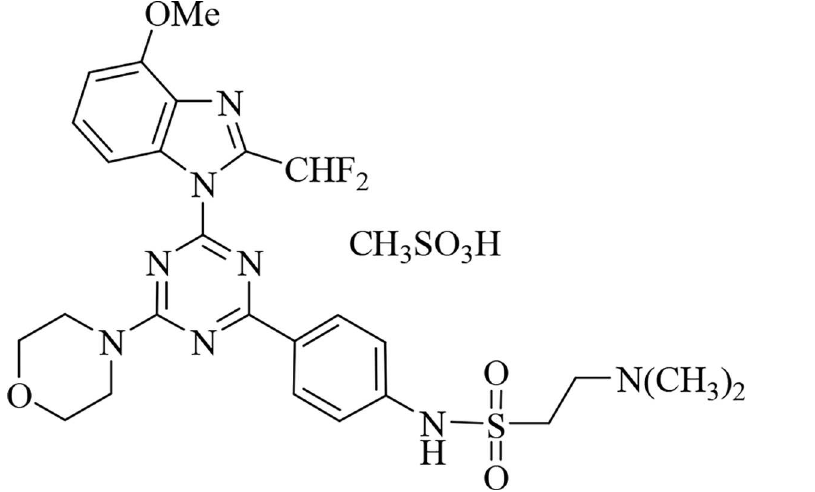
Fig 1. Chemical structure of